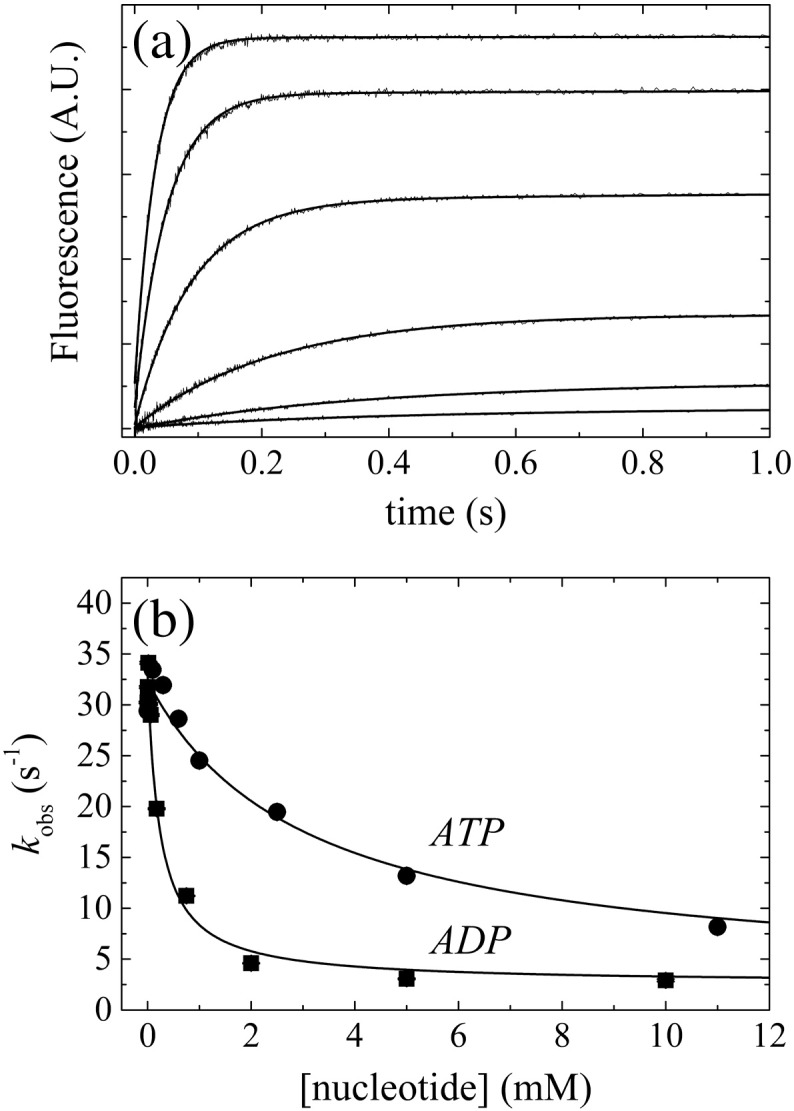
Unlabeled nucleotide binding affinity measured by competition with mant nucleotides. (a) Time courses of fluorescence change after mixing 0.5 μM Dbp5 with 50 μM mantADP and 0, 0.175, 0.75, 2, 5, or 10 mM ADP (upper to lower). Continuous lines through the data represent best fits to two exponentials. (b) [nucleotide] Dependence of the fastest observed rate constant (k1,obs) after mixing 0.5 μM Dbp5 with a solution of 50 μM mantADP supplemented with 0, 0.1, 0.3, 0.6, 1, 2.5, 5, or 11 mM ATP (black squares). Black circles represent the fastest observed rate constant of mantADP binding on mixing 0.5 μM Dbp5 with a solution of 50 μM mantADP supplemented with 0.005, 0.015, 0.03, 0.0625, 0.175, 0.75, 2, 5, or 10 mM ADP. Continuous lines represent best fits to Eq. (13).